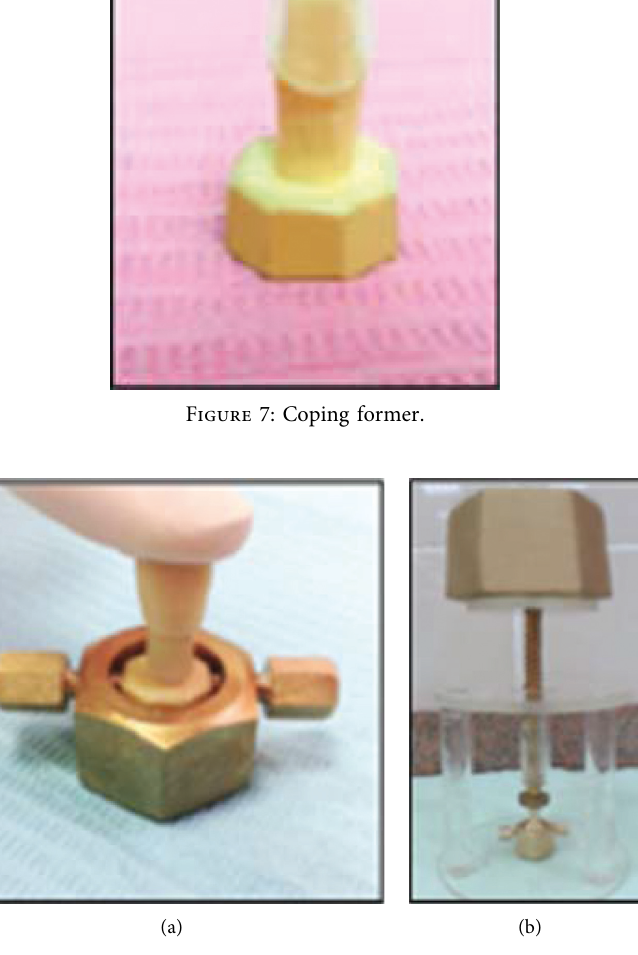
Figure 8: Seating the crown after cementation (a) under finger pressure and (b) under static load of 5kg.